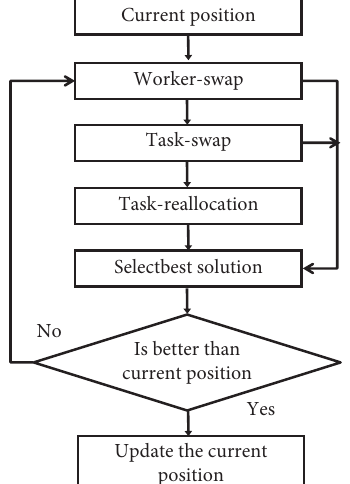
Figure 6: Smell-based search procedure.